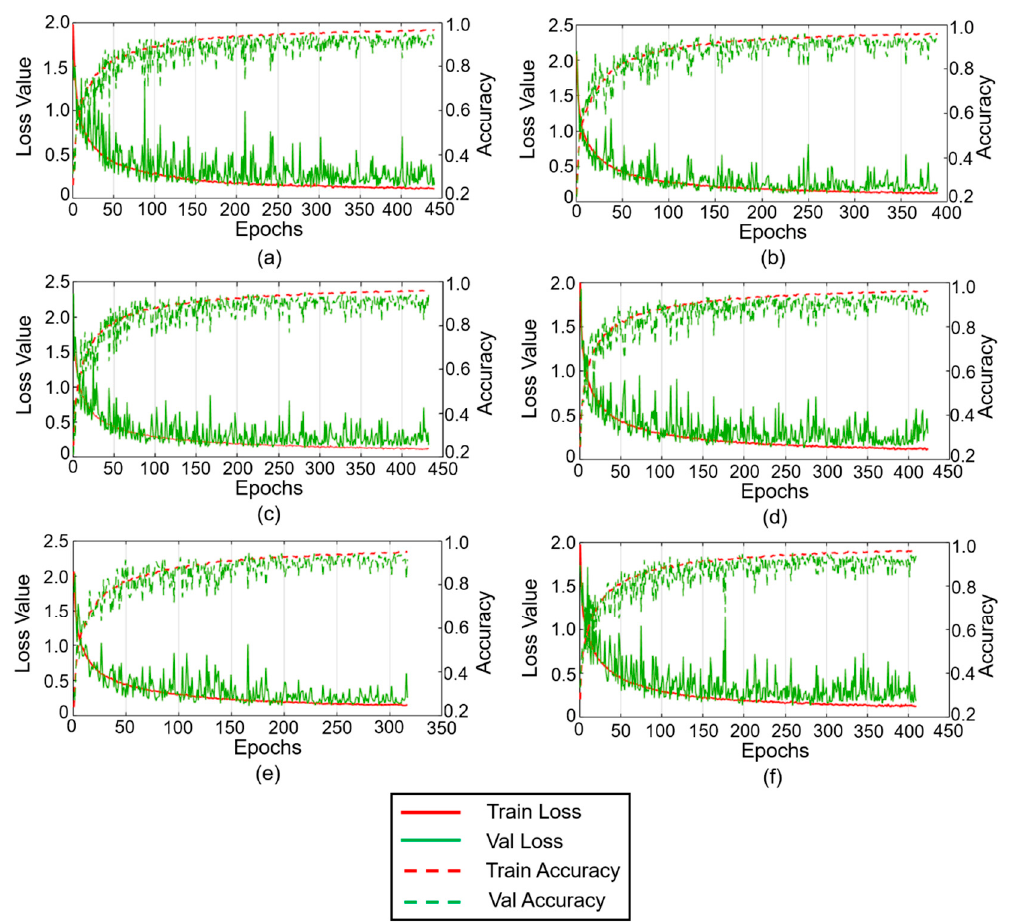
Figure 4. The convergence curves obtained after training the DNN on residual signals computed after the DUDAE was trained during ( a ) 100 epochs, ( b ) 200 epochs, ( c ) 300 epochs, ( d ) 400 epochs, ( e ) 500 epochs, and ( f ) 600 epochs, respectively.